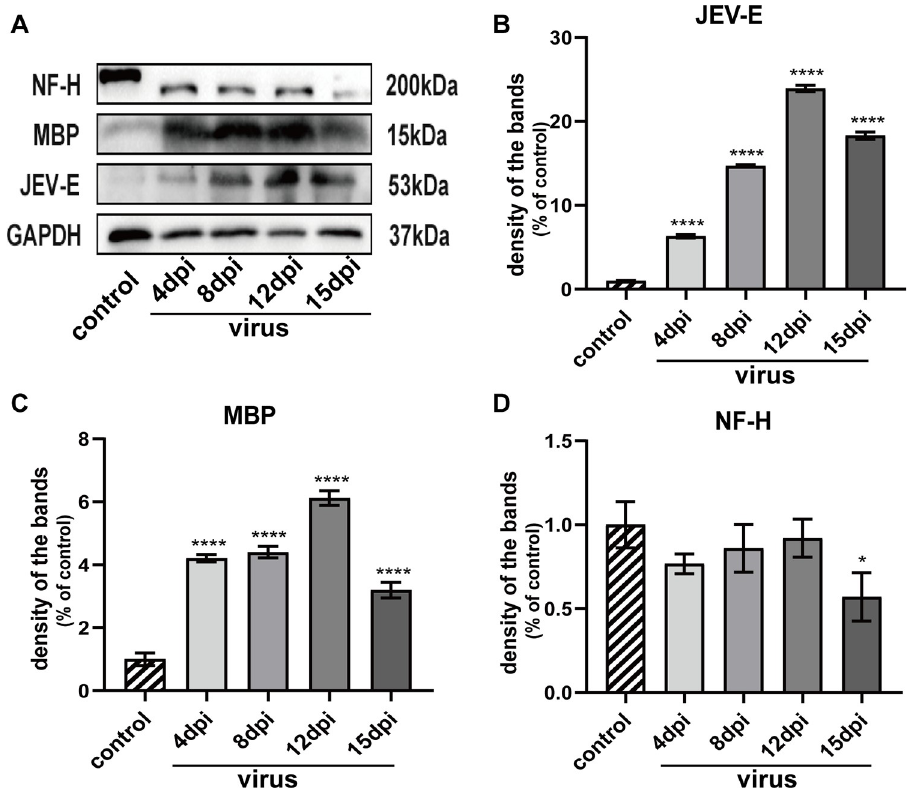
Fig 5. Western blot analysis of related protein expression levels. Statistical analysis by one-way ANOVA. (A) The protein expression was detected by Western blot. Using GAPDH as the reference, the changes of relative expression of different proteins at different time were compared. (B) Relative expression of JEV-E protein at different time; (C) Relative expression of MBP protein at different time; (D) Relative expression of NF-H protein at different time.